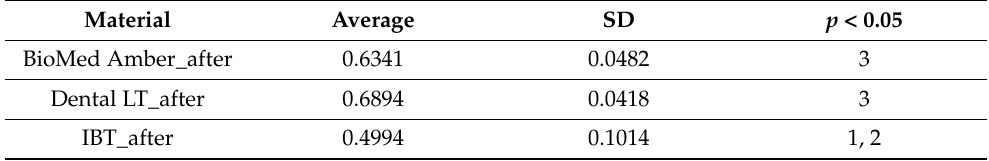
Table 15. Post hoc ANOVA results (least significant difference) for comparing the BI values of each material after the compression test (SD—standard deviation; n.s.—nonsignificant